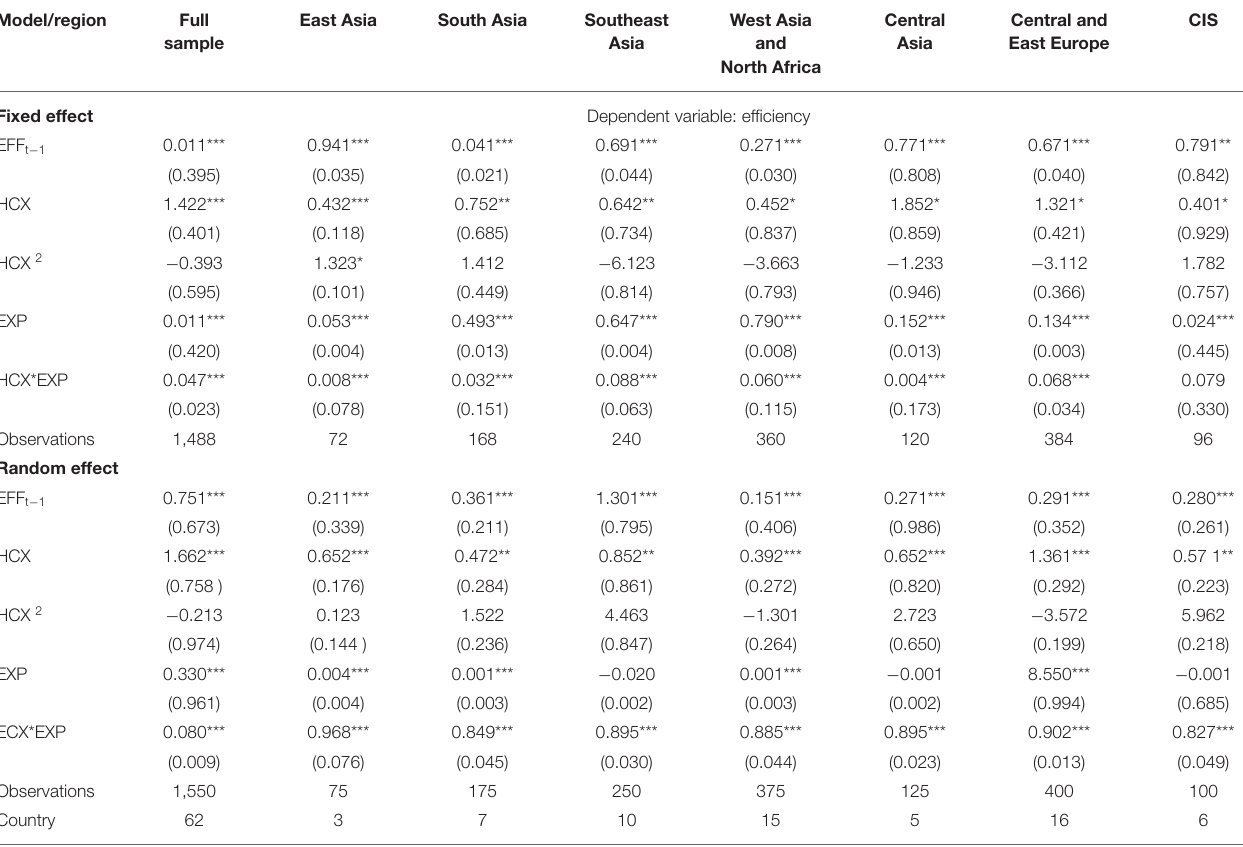
TABLE 7 | Regional analysis of BRI (economic efficiency